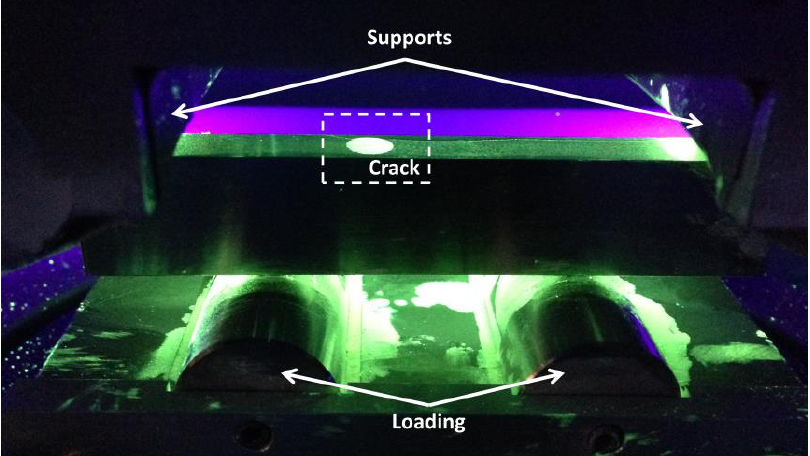
Figure 6. Crack location on additive manufactured samples by means of liquid penetrant inspection (LPI) level 2 under static